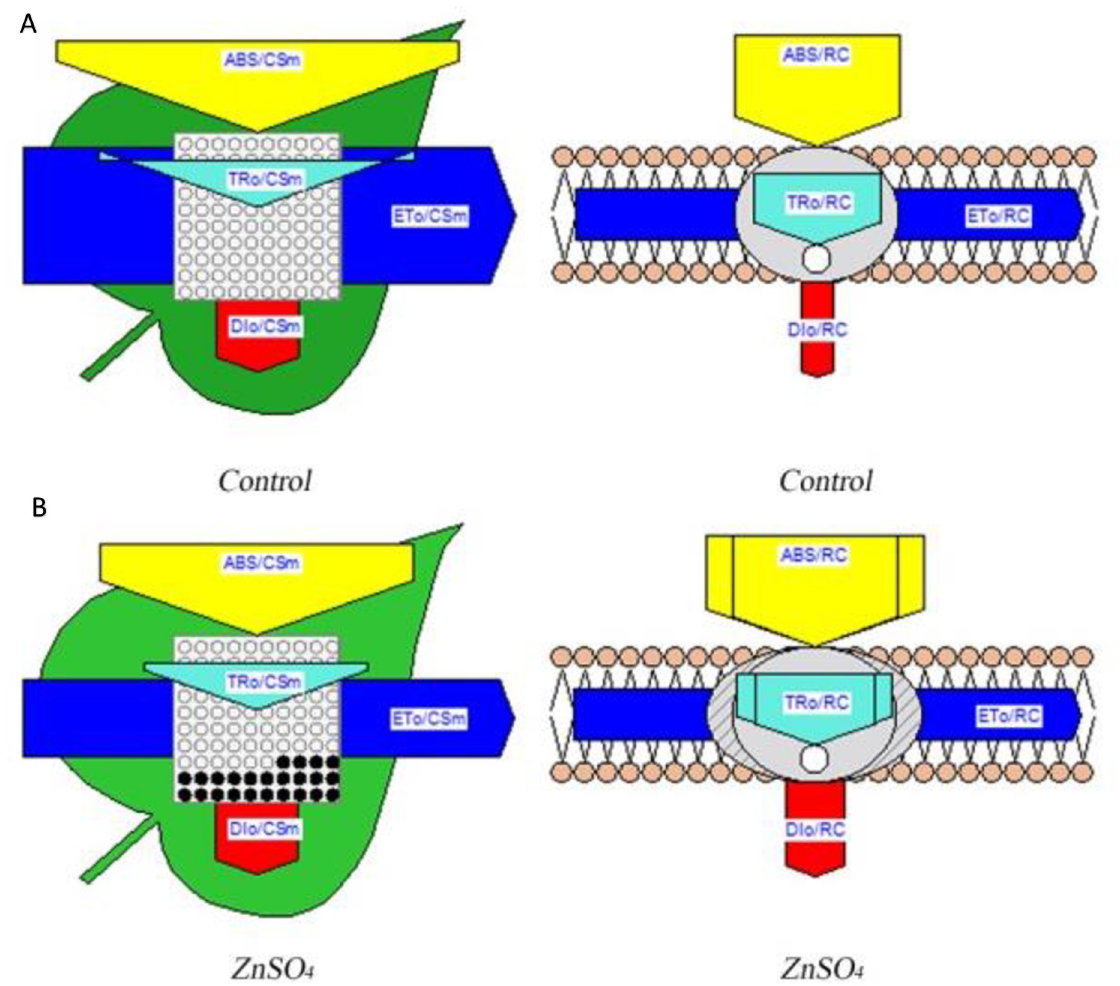
Fig 3. Energy pipeline leaf model (A & B) of phenomenological fluxes (per cross section, CSm and per reaction centre, RC) in A . ilicifolius L. leaves treated with ZnSO 4 (4